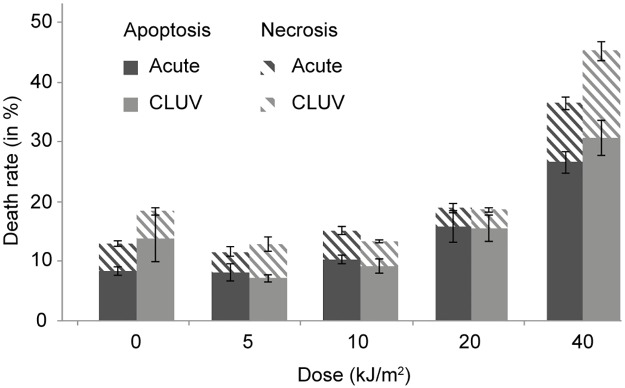
Effect of a CLUV pre-stimulation on UV-induced cell death sensitivity.NHDF CLUV pre-stimulated (CLUV) or not (Acute) were irradiated with UVB doses ranging from 0 to 40,000 J/m2. Sensitivity to UV-induced apoptosis and necrosis was assessed by FACS analysis, 16 h post-irradiation. Dashed bars represent the percentage of necrotic cells and solid bars are apoptotic cells. Data are expressed as means ± SEM of four independent NHDF cell strains (N = 4). Significance was evaluated using the student’s t-test.